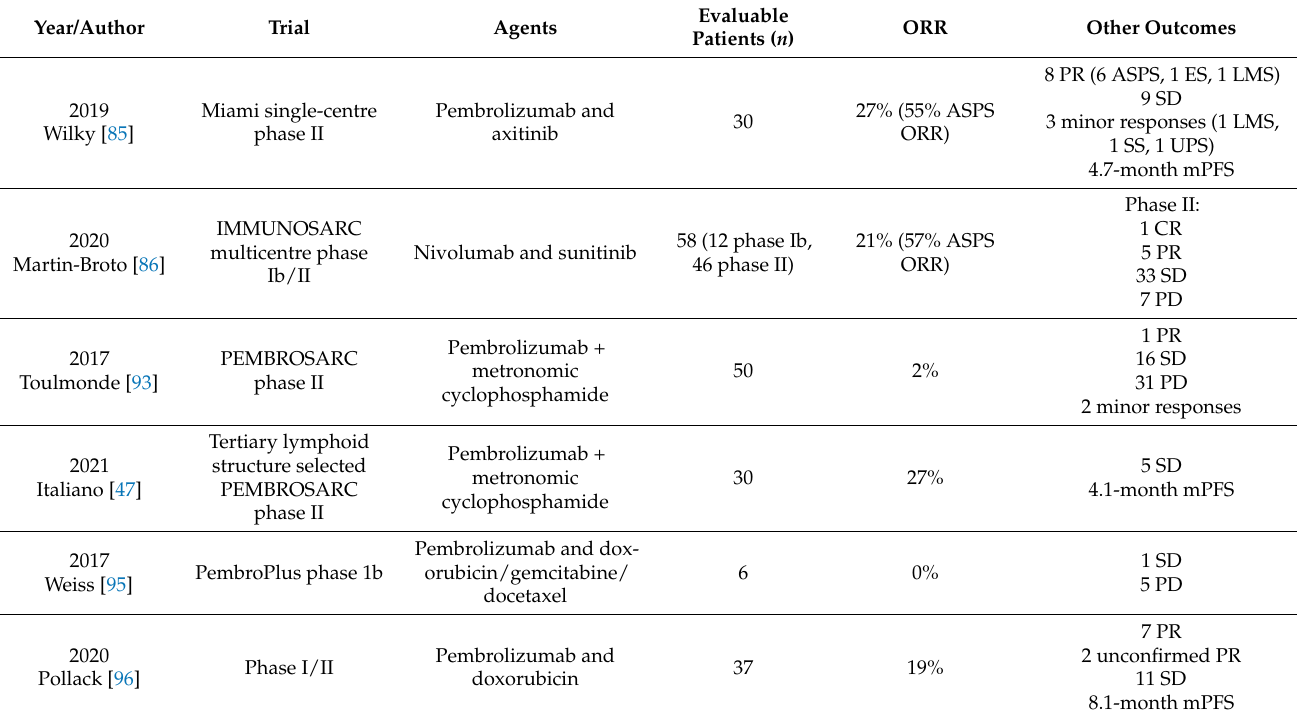
Table 4. Combinatorial CPI clinical trials in